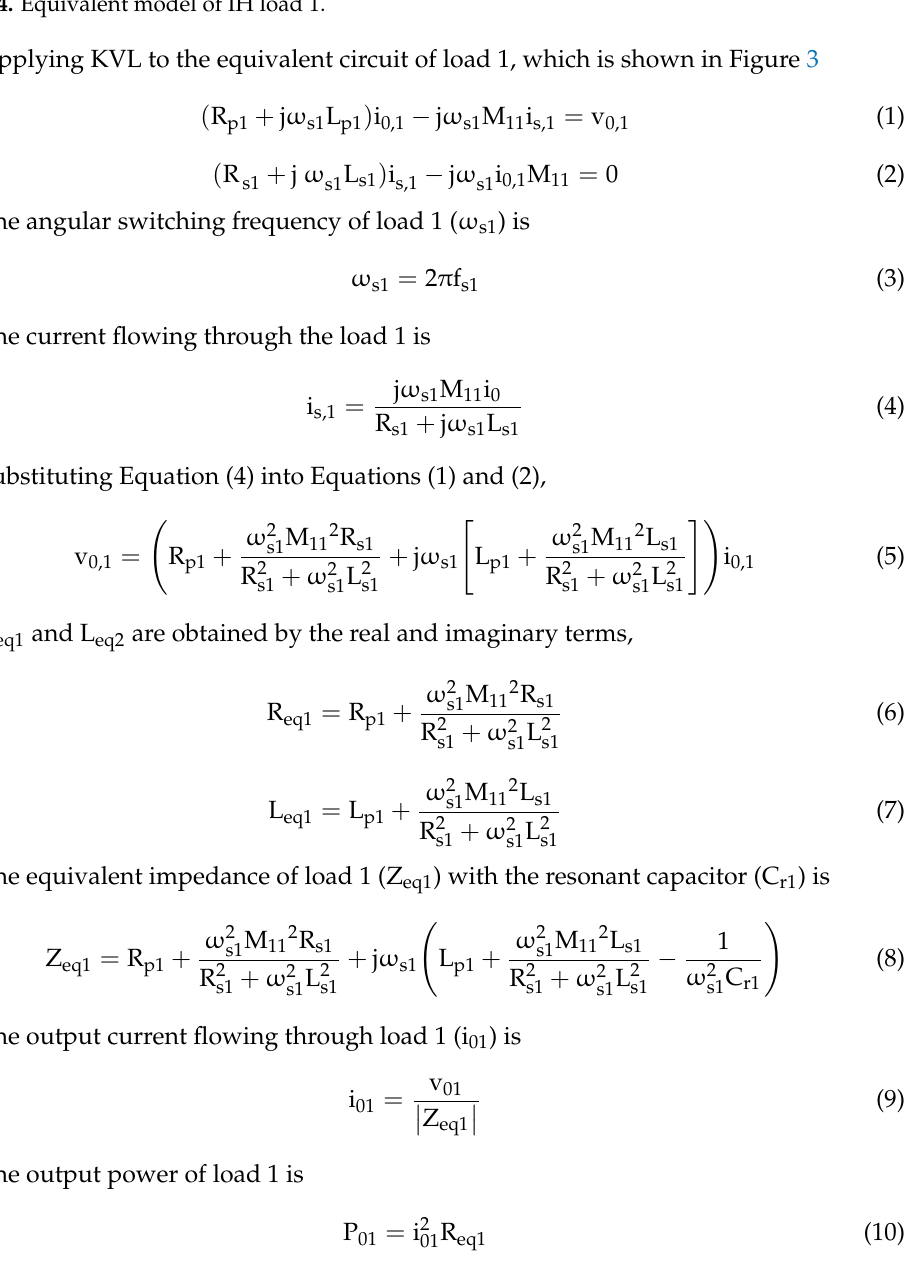
Figure 4. Equivalent model of IH load 1.